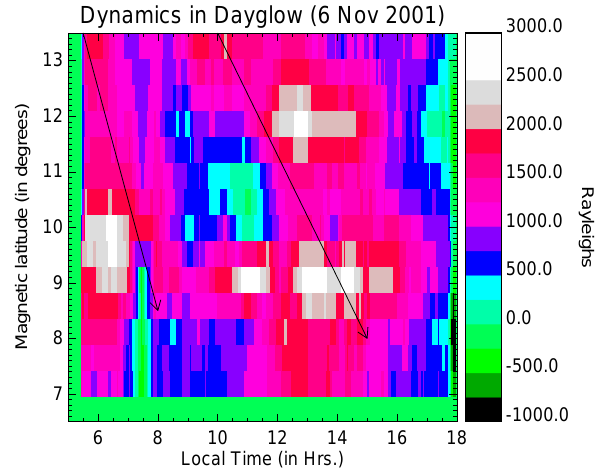
Fig. 6. Two-dimensional plots of the dynamical component in the dayglow for 5 November 2001. The x axis represents the local time and y axis indicates the approximate magnetic latitude in the South- ern Hemisphere from where the emissions are assumed to have orig- inated. A constant emission altitude of 230km has been assumed to estimate the magnetic latitudes. The color scale indicates the bright- ness variation due to the dynamics of the upper atmosphere in the red line emission region (similar to the bottom panel of Fig. 2). A peak is seen centered at around 13:00 LT at 9 ◦ magnetic latitude, which is most likely the response to the EIA development. This weaker development of the EIA as seen in the dayglow emissions, is an indication of weaker equatorial electrodynamics and hence no post-sunset ESF is expected for this night. Compare this day with the 7 November data (Fig. 8) when a stronger EIA development occurred.